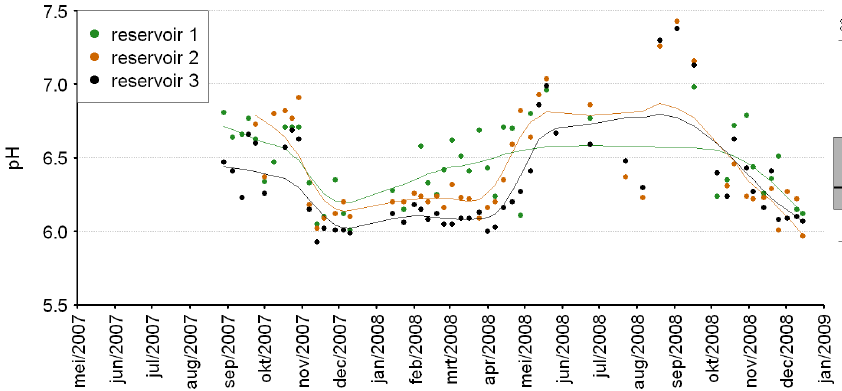
Figure 4. Time series of pH of reservoir water. Remarks as for Fig. 2.